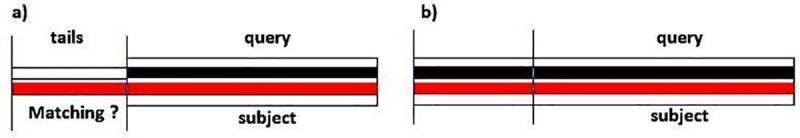
Codon Settings.Start codon adjustment process based on the information in the database; (a) analysis between query and subject, (b) result after adjustments.